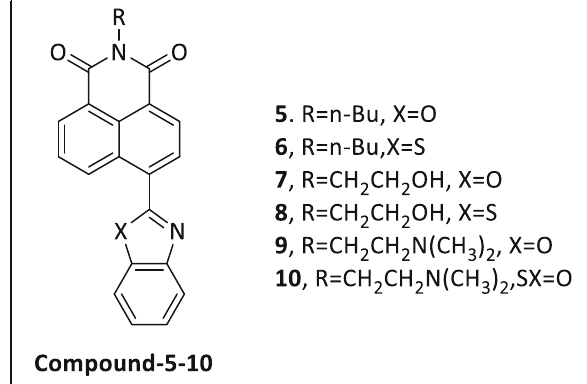
Fig. 36 C4 benzoxazole naphthalimide